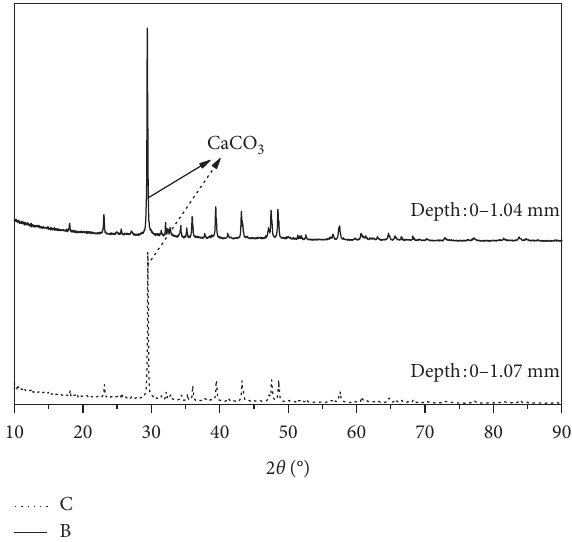
Figure 6: Comparison of CaCO 3 peak intensity within about 1 mm of the surface layer.